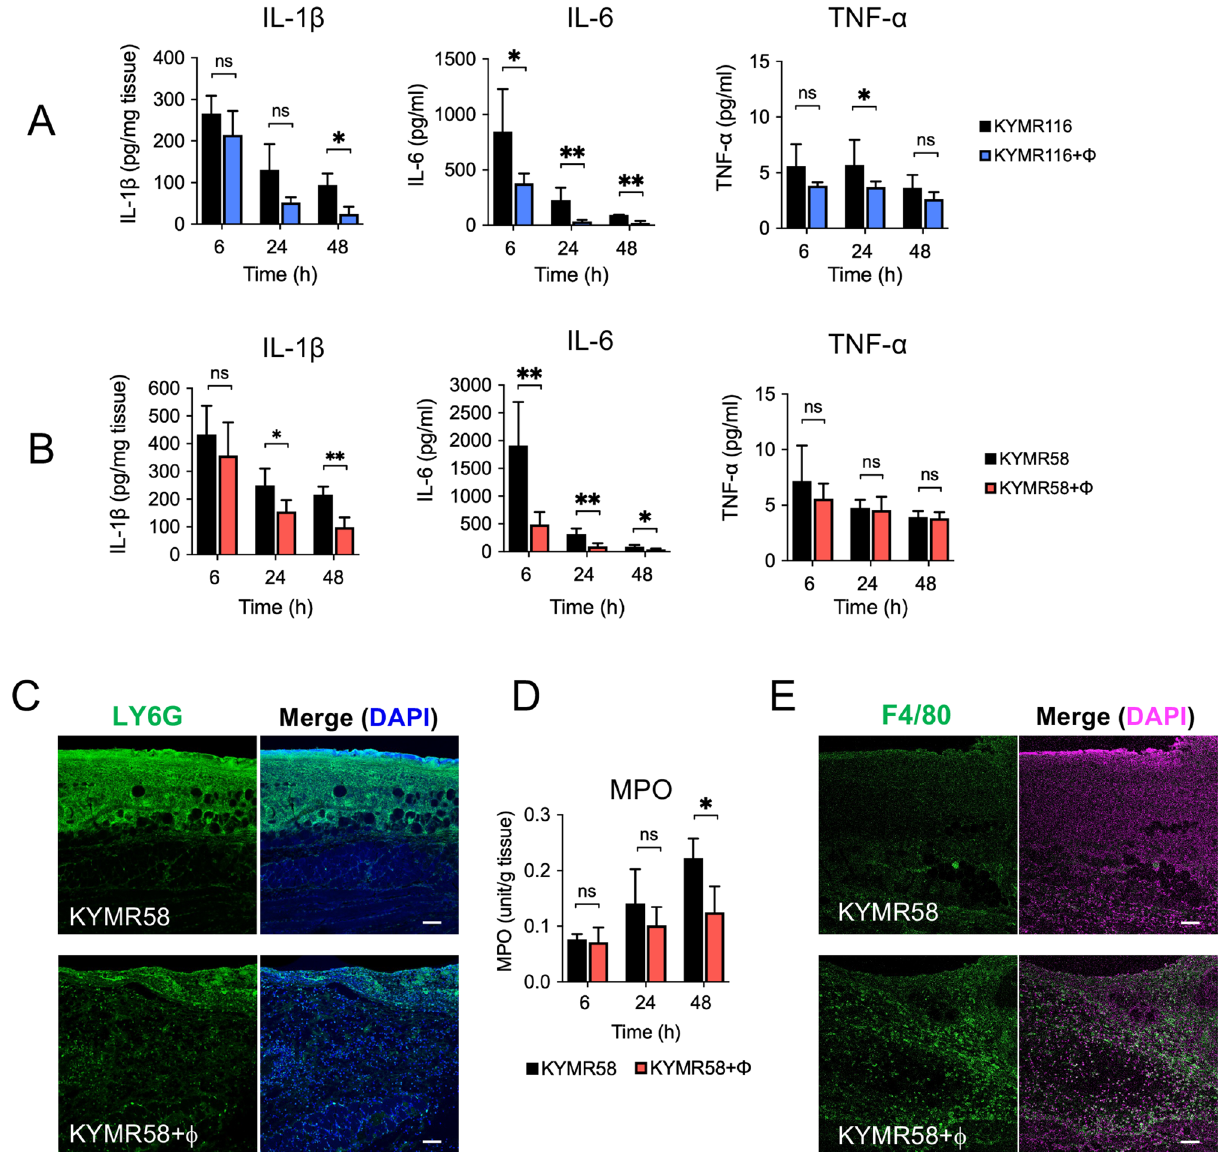
Figure 6. Effects of phiMR003 on the inflammatory responses induced by MRSA. Samples were prepared at 24 h after infection with KYMR116 or KYMR58 followed by the administration of phiMR003 (KYMR116 +ϕ or KYMR58 + ϕ) or SM buffer (KYMR116 or KYMR58) to the mice. IL-1β, IL-6, and TNF-α in the samples were quantified by ELISA (n = 5) after infection with KYMR116 ( A ) and KYMR58 ( B ). Error bars indicate the standard errors of the means (SEMs). *, P < 0.05; **, P < 0.01. Representative data from three repeated experiments are shown. The detection of neutrophils ( C ) and macrophages in mouse skin tissue ( E ) by immunofluorescent staining with anti-Ly-6G (green) and anti-F4/80 (green) antibodies. Nuclei are stained with DAPI (blue or magenta). Neutrophils in the tissues were quantified by myeloperoxidase assay ( D ). Scale bars, 100